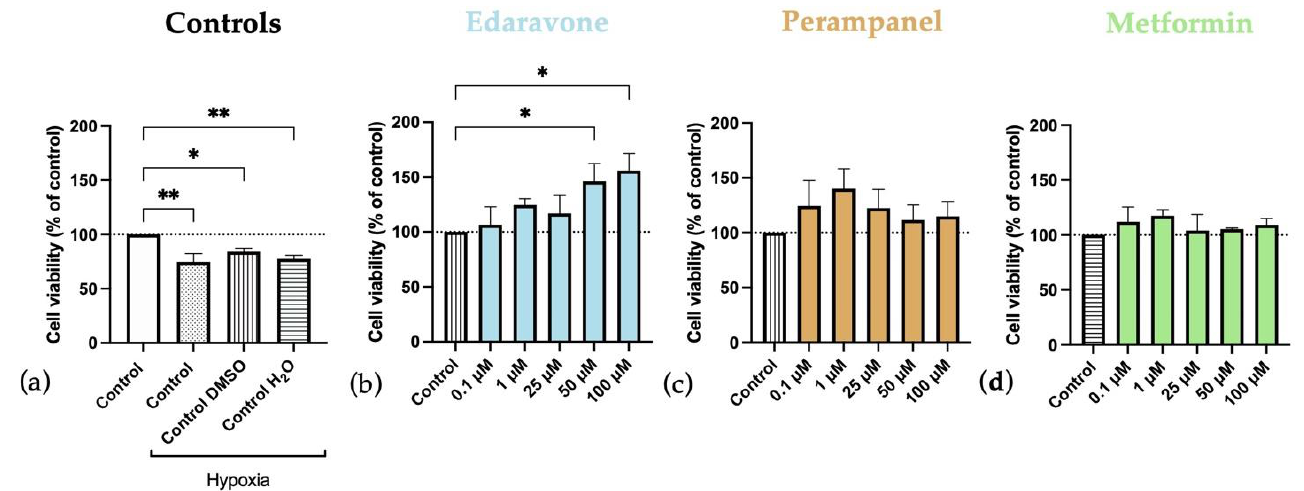
Figure 6. Effects of hypoxia, and edaravone, perampanel, and metformin treatments on HT-22 cells viability. Hypoxia and drugs were applied simultaneously for 48 h. ( a ) Controls graph, comparing controls/vehicles under hypoxic conditions to normoxia ones. ( b ) Edaravone, ( c ) Perampanel, and ( d ) Metformin treatments, while under hypoxia. Cell viability was evaluated by using the MTT assay. Results are expressed as the percentage of cell viability relative to respective untreated hypoxia control cells. * and ** indicate p < 0.05 and p < 0.01, respectively, when compared to the respective control under hypoxia conditions. All data are presented as the mean + SEM of three independent